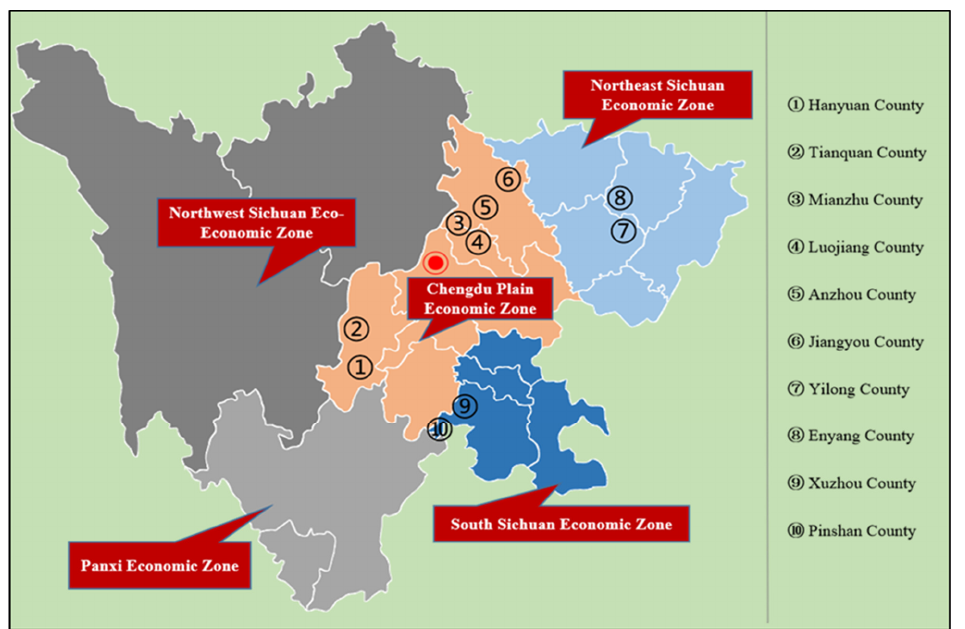
Figure 1. Geographical distribution of sample counties in Sichuan Province.